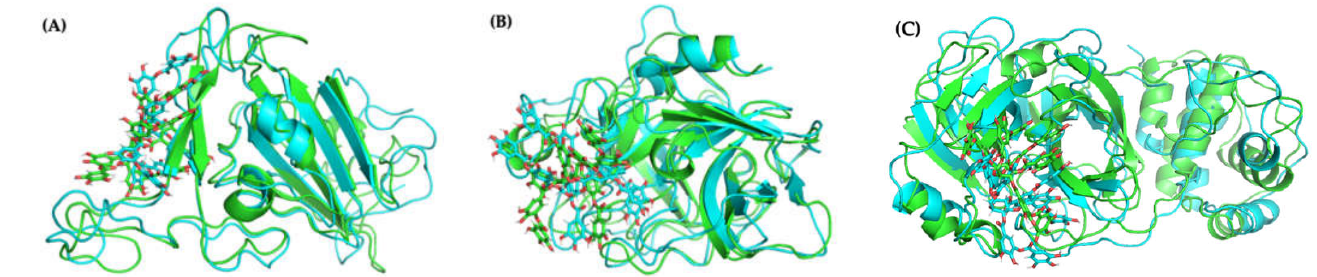
Figure 8. Molecular structures (pose 1) of: ( A ) TA/RBD, ( B ) TA/TMPRSS2, and ( C ) TA/3CLpro complexes, before (green) and after (turquoise) 1000-ns MD simulations.